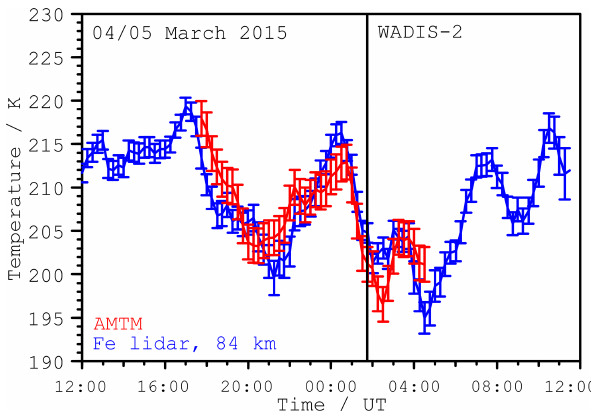
Figure 10. Time series of OH temperatures (red) in comparison with the Fe lidar temperatures (blue). Lidar temperatures are av- eraged in altitude with a Gaussian weighting of 9km FWHM and peak altitude of 84 ± 1km. Temperatures of the AMTM are taken from a sub-array of 9 pixels × 9 pixels at the location of the Fe lidar and smoothed by a 60min running